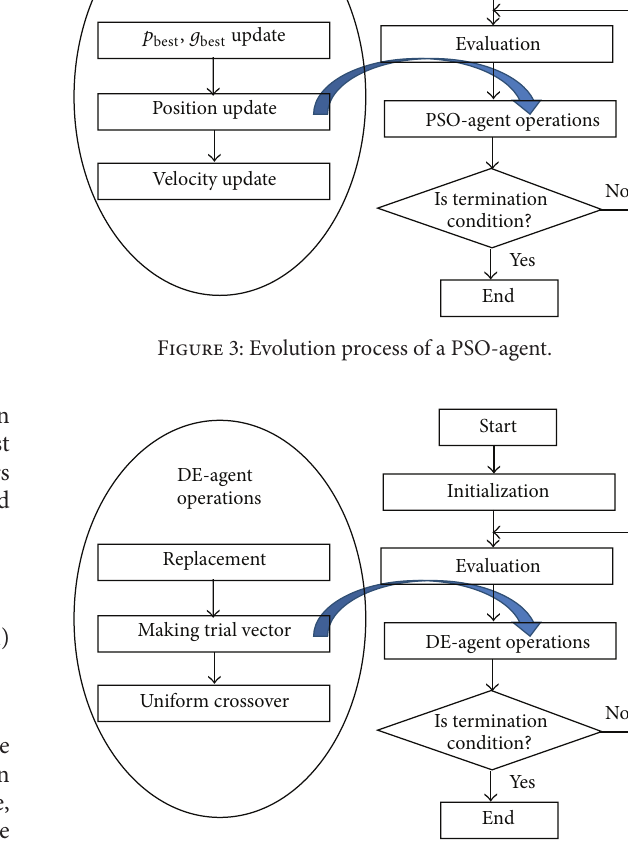
Figure 4: Evolution process of a